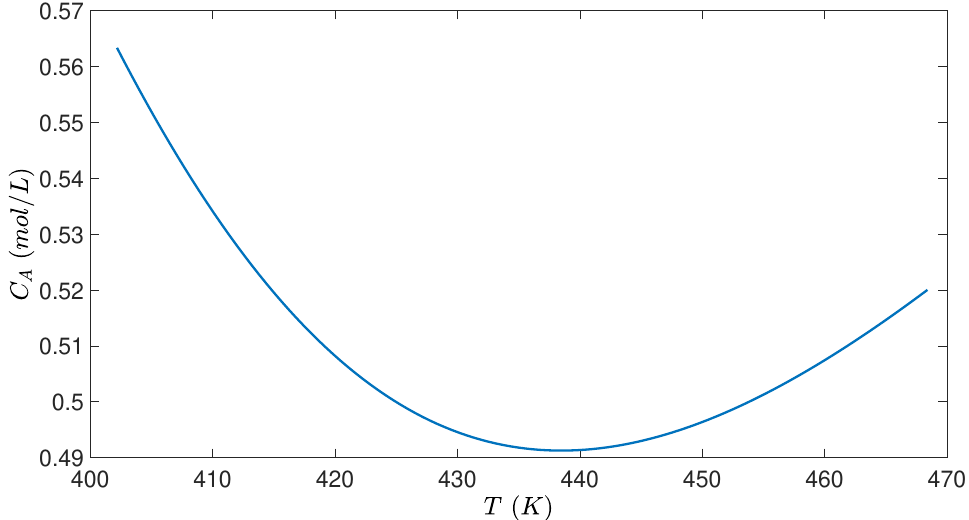
Figure 2. Steady-state profiles ( C A and T ) for the CSTR of Equation (8) under varying heat input rate Q , where the minimum of C A is achieved at Q= 59,983